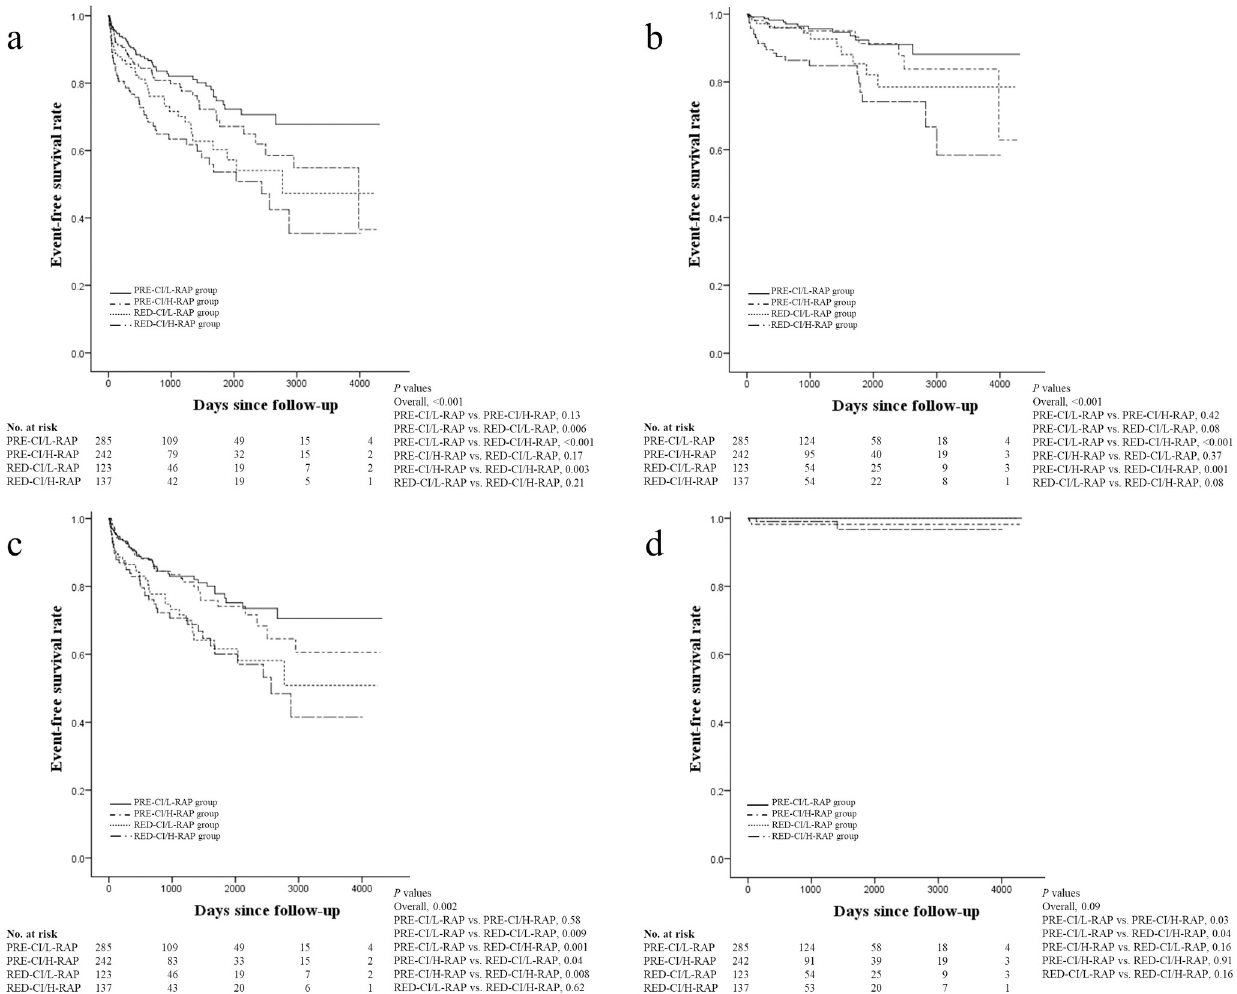
Fig 2. Kaplan-Meier curves for (a) major adverse cardiovascular events, (b) cardiac death, (c) readmission due to heart failure, and (d) implantation of a left ventricular assist device in the four groups. Comparison of the survival curves was performed using the log-rank test.